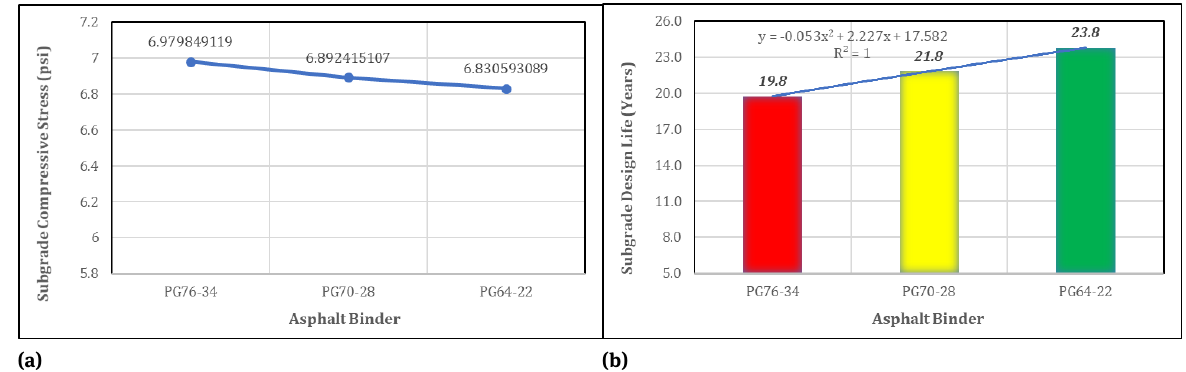
Figure 19: Effect of binder type on subgrade compressive stress (a) and on subgrade design life (b) in asphaltic overlayment tTrack.